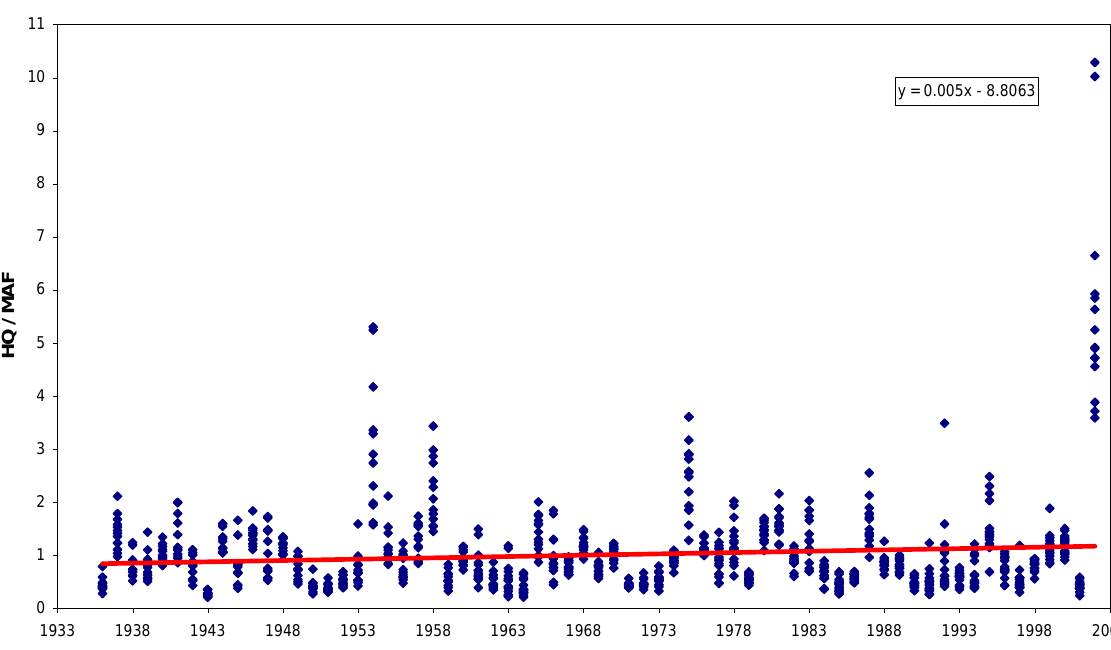
Fig. 3. Regional trend test based on discharge data of 15